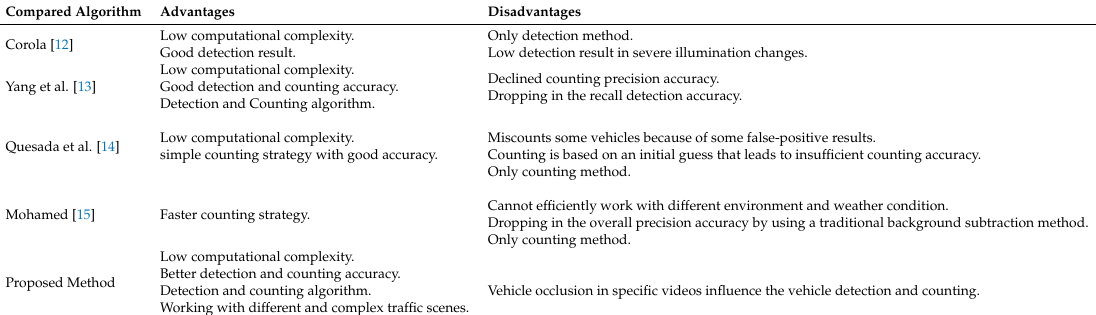
Table 1. Evaluation summary with the state of